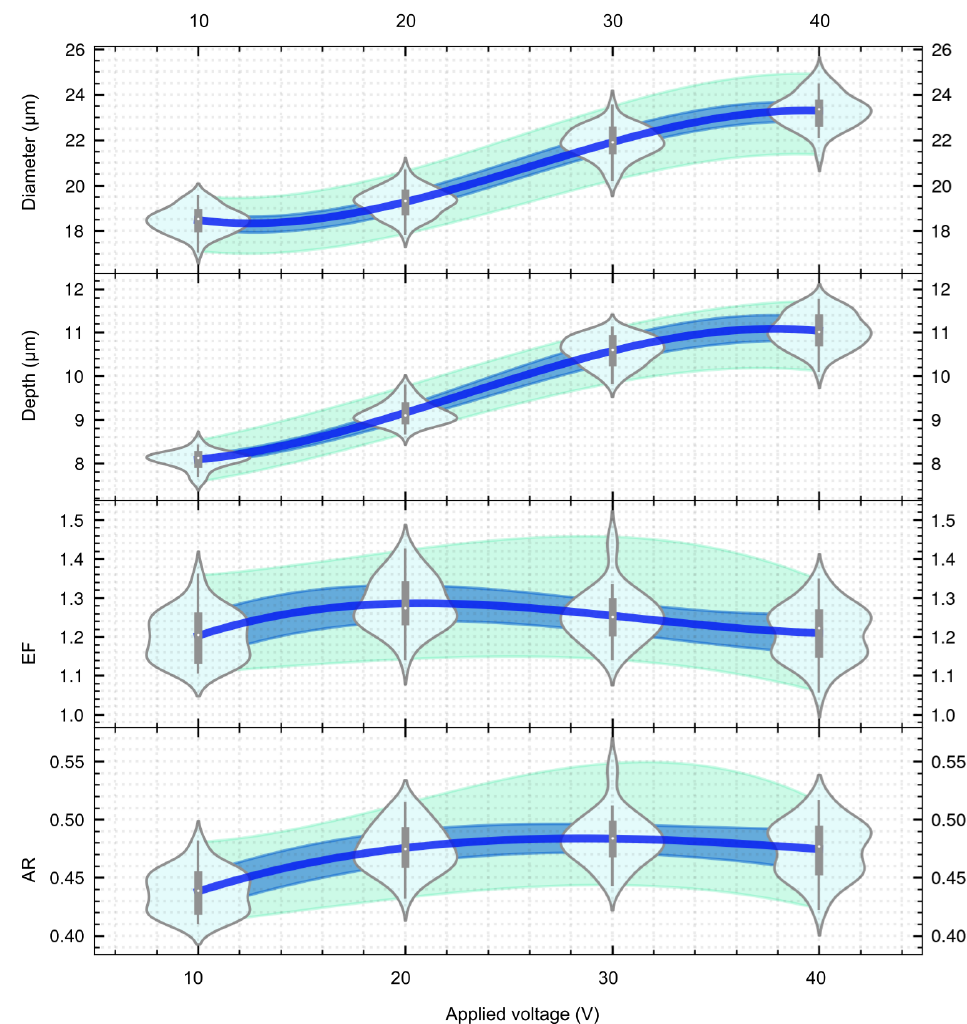
Figure 6. The effect of voltage on the dimensions of micro